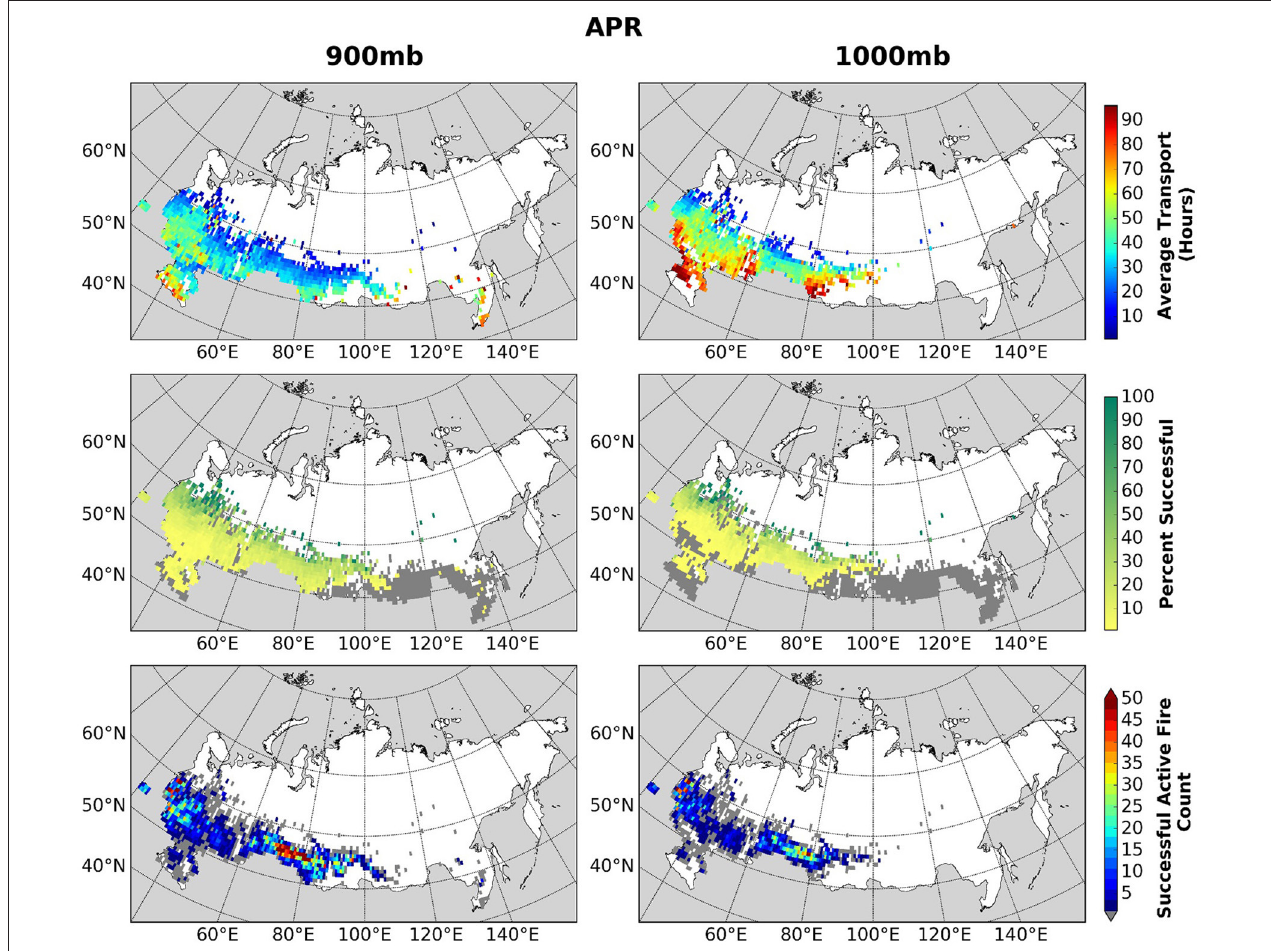
FIGURE 7 | 900 and 1,000mb April 2003–2015 average transport (hours), percent successful and active fires potentially contributing to BC deposition on snow in the Arctic. The dark gray color in the percent successful maps (middle) represents the starting fire locations which were unsuccessful at reaching the snow in the Arctic within